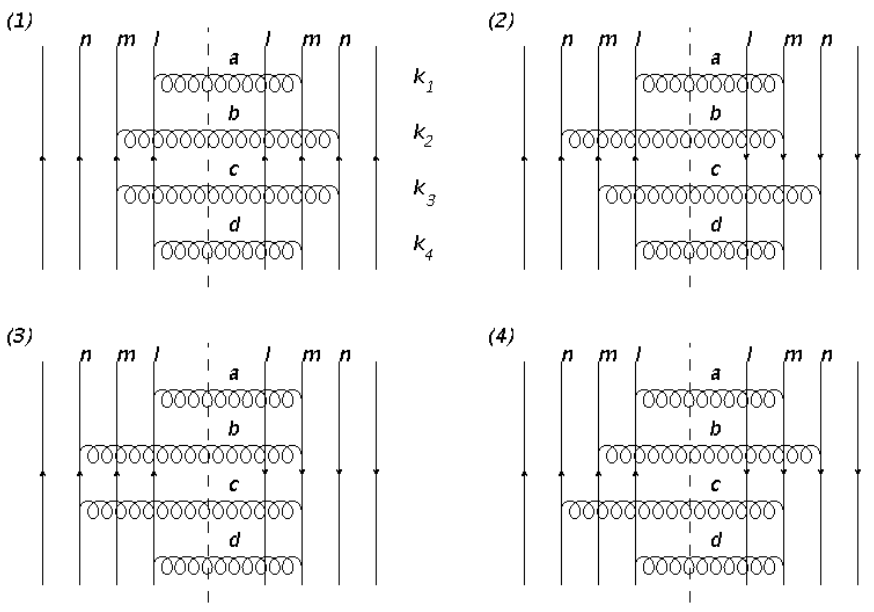
Figure 4 . A set of diagrams that contribute to the sin-terms in (B.13), and thus to odd azimuthal